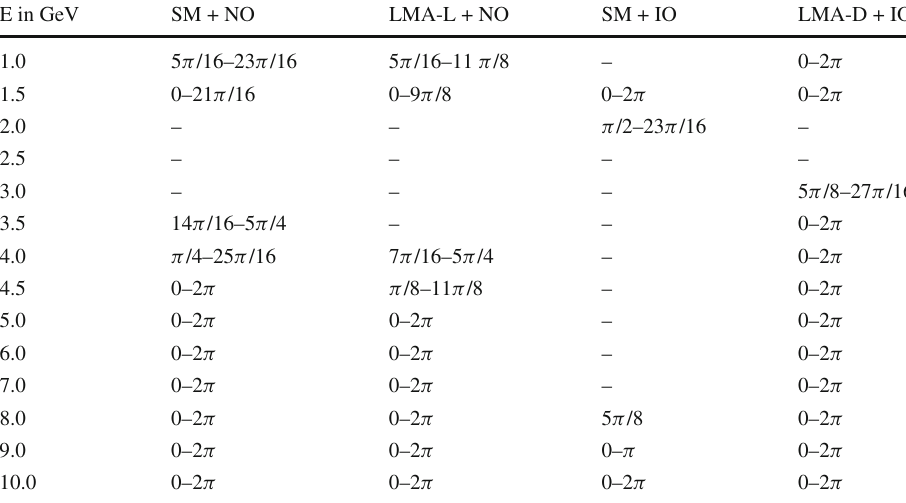
Fig. 1 K 3 has been plotted in the E − δ plane in case of SM-interaction with NO (first), LMA-Light + NO (second), SM + IO (third) and LMA-Dark + IO scenario (fourth) in the context of DUNE experiment ( L = 1300 km, E = 1 − 10 GeV) Table 3 Specific ranges of